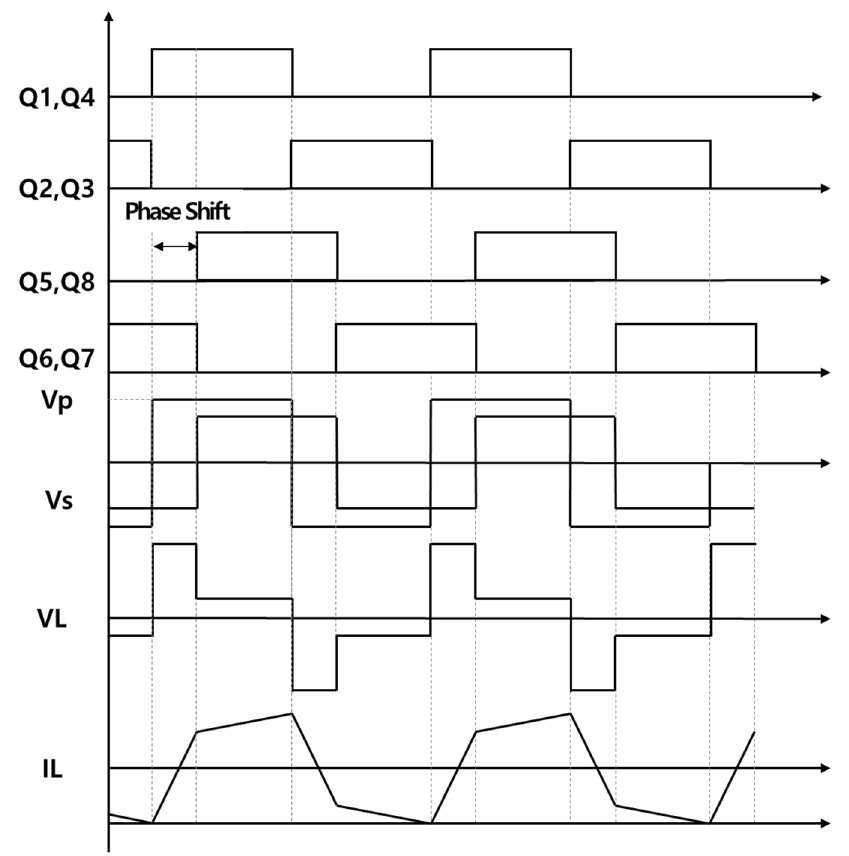
Figure 2. SPS control DAB converter operation waveform.